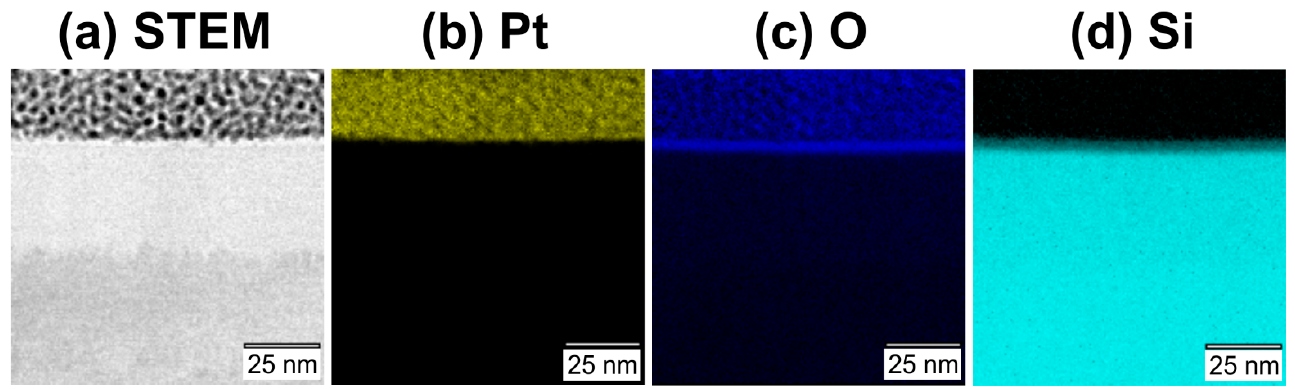
Figure 7. STEM image ( a ) and elemental energy dispersive X-ray spectroscopy (STEM-EDX) maps of platinum (Pt, yellow, ( b )), oxygen (O, blue, ( c )), silicon (Si, cyan, ( d )).